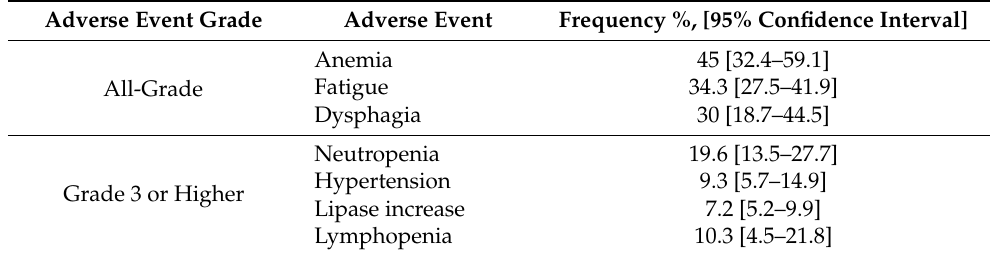
Table 3. Most commonly reported adverse events linked to PD-1 or PD-L1 inhibitor-based combina- tion therapies (summarized from Zhou et al. 2021